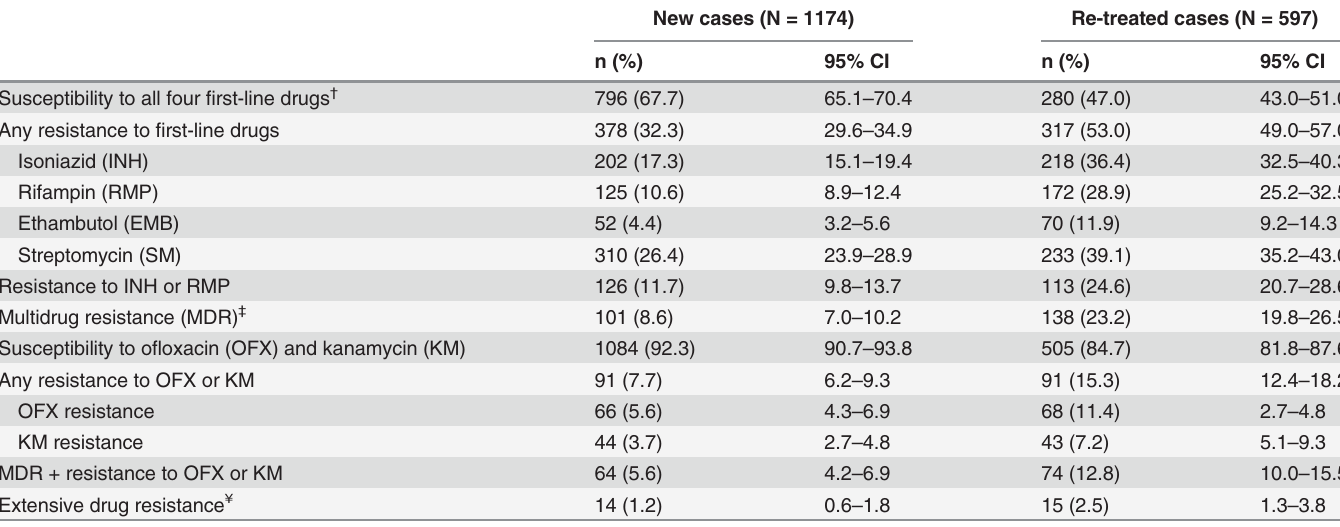
Table 1. Resistance to fi rst- and second-line antituberculosis